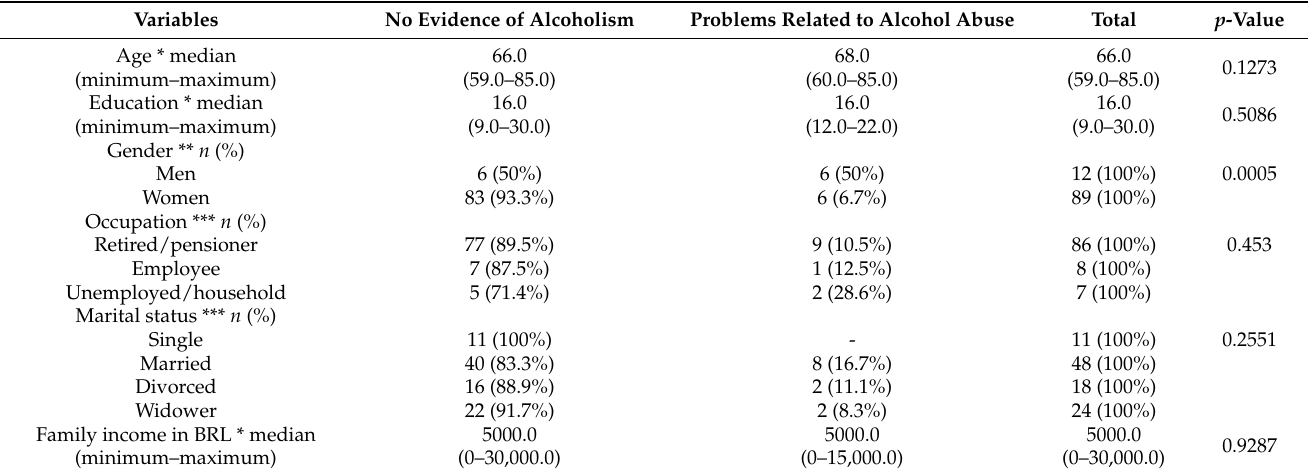
Table 2. Association of sociodemographic variables with alcohol use/abuse (Michigan Alcoholism Screening Test–Geriatric Version—MAST-G) of elderly people enrolled at the Open University for Elderly People ( n = 101).